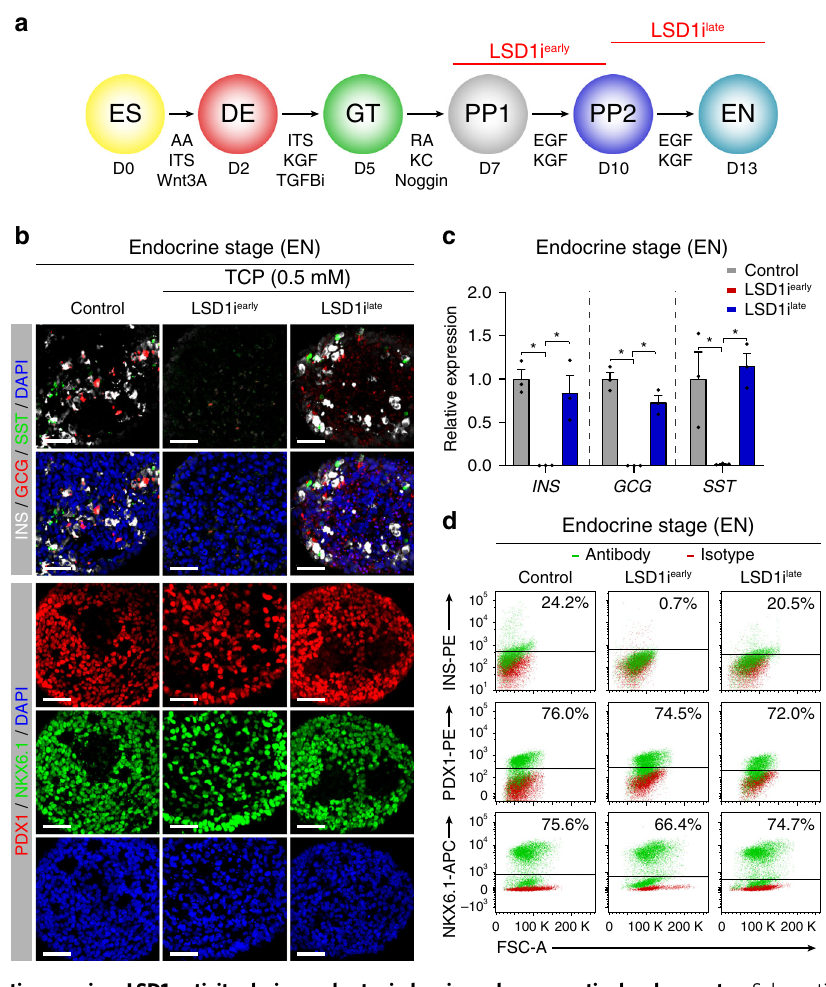
Fig. 1 Endocrine cell formation requires LSD1 activity during a short window in early pancreatic development. a Schematic of the human embryonic stem cell (hESC) differentiation protocol to the endocrine cell stage (EN) and experimental plan for LSD1 inhibition. b Immuno fl uorescent staining for pancreatic hormones insulin (INS), glucagon (GCG) and somatostatin (SST) or PDX1 and NKX6.1 in control EN cells compared to EN cells with early (LSD1i early ) and late (LSD1i late ) LSD1 inhibition (representative images, n = 10 independent differentiations). Scale bar, 50 µ m. c qRT-PCR analysis for INS ,